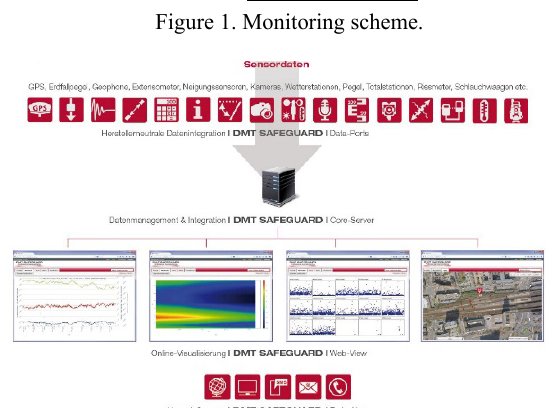
Figure 1. Monitoring scheme.